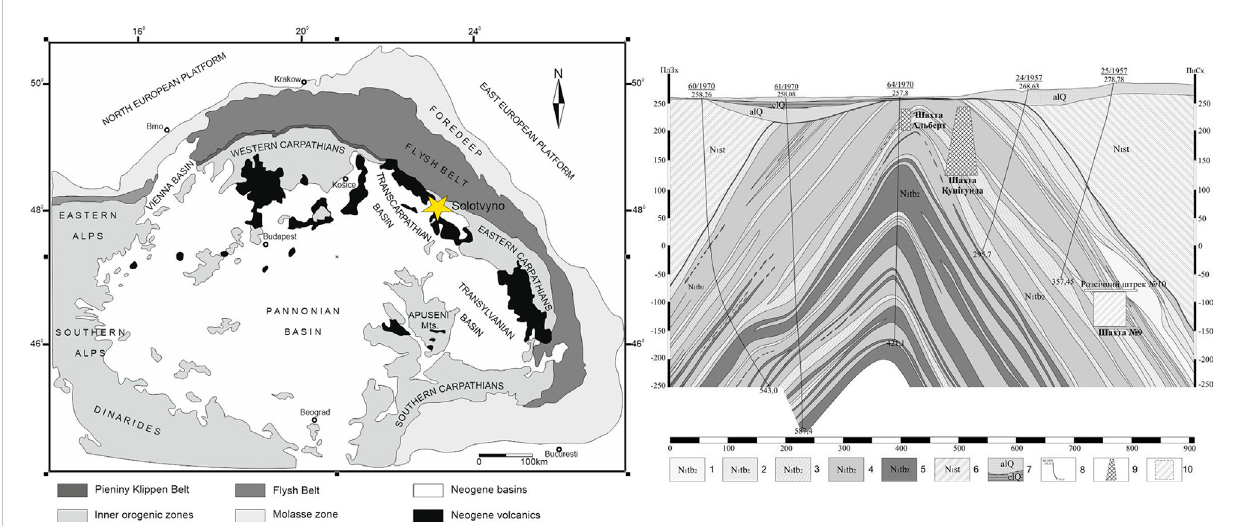
FIGURE 1 Main geological units distribution in Central Europe and geological sections of the Solotvyno rock salt deposit (Jacko et al., 2016; Yakovlev et al., 2016). 1 — Tereblianska suite, alternating rock salt: white, water-insoluble residue (i.r.) content up to 2%; 2 — tereblianska suite, alternating rock salt: white, lightgray, contentupto2.5%;3 — Tereblianskasuite,alternating rocksalt:lightgrayandgray,contentlessthan3%;4 — Tereblianskasuite,alternatingrock salt: gray, earthy, content more than 3%; 5 — Tereblianska suite, alternating: clays, mudstones; 6 — Solotvynska site. Alternating: siltstone